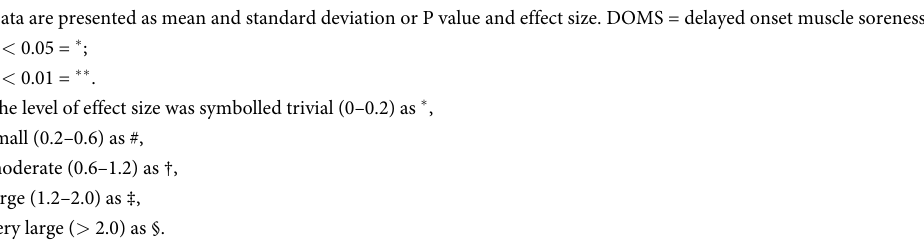
(Table 3). The coefficient of variation (CV) of mean sRPE was lowest in the 1 st OTC (17.4 ± 10.7%) and largest in the 3 rd OTC (39.8 ± 19.8%). The qualitative magnitude was very